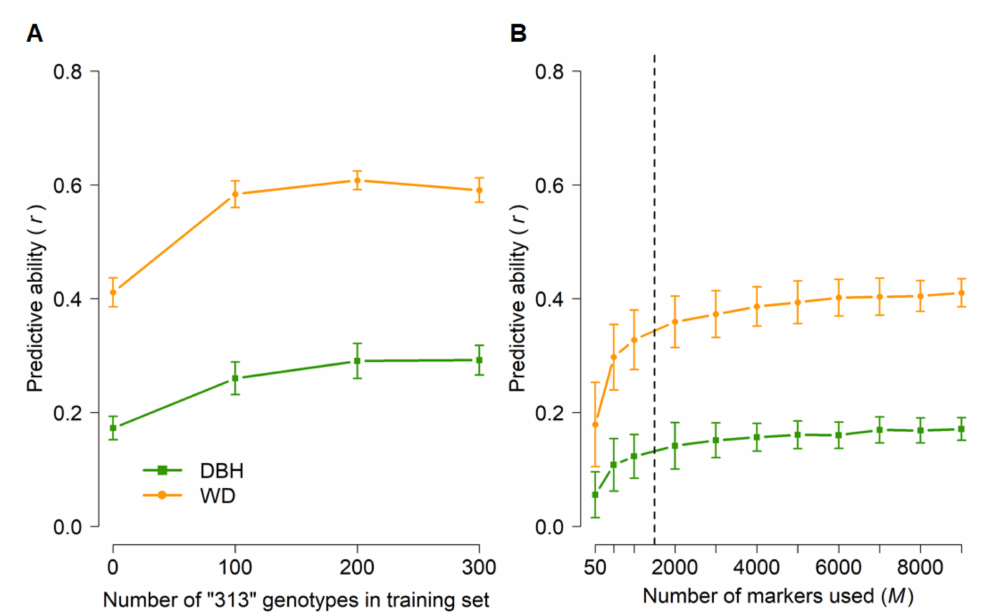
Figure 5. Genomic predictive abilities across populations for diameter at breast height (DBH) and wood density (WD) as a function of the number of “313” genotypes included in the training set ( A ) and the number of markers ( B ) used in cross-validations across populations. Error bars correspond to standard deviations across 100 iterations for each set of parameters. For analyses in ( A ), a training set of 800 genotypes (including the desired number of “313” genotypes) was randomly sampled from the total number of 1761 genotypes (Table 1) and all 9353 SNPs were used. The training set in ( B ) was selected at random ( N = 800), with no “313” genotypes included, and subsets of markers were selected at random. All predictive abilities were only for “313” genotypes that were not included in the training set ( N = 381–681, see Materials and Methods and Table 1). The dashed line in ( B ) indicates the plateau in predictive ability.